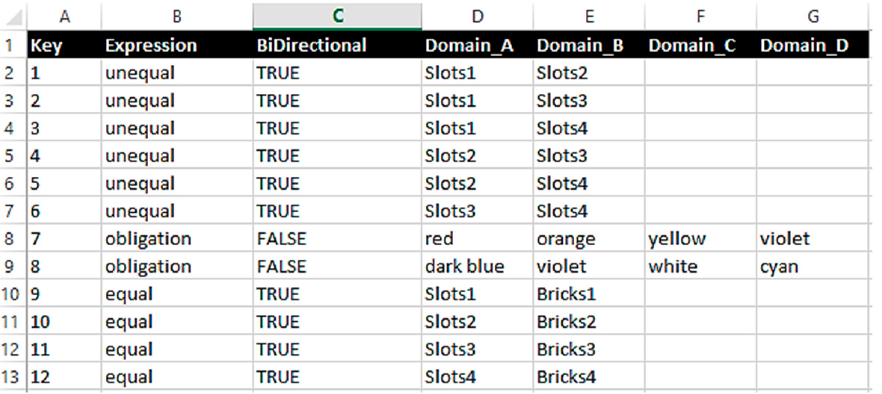
Figure 7. Spreadsheet constraint definition.